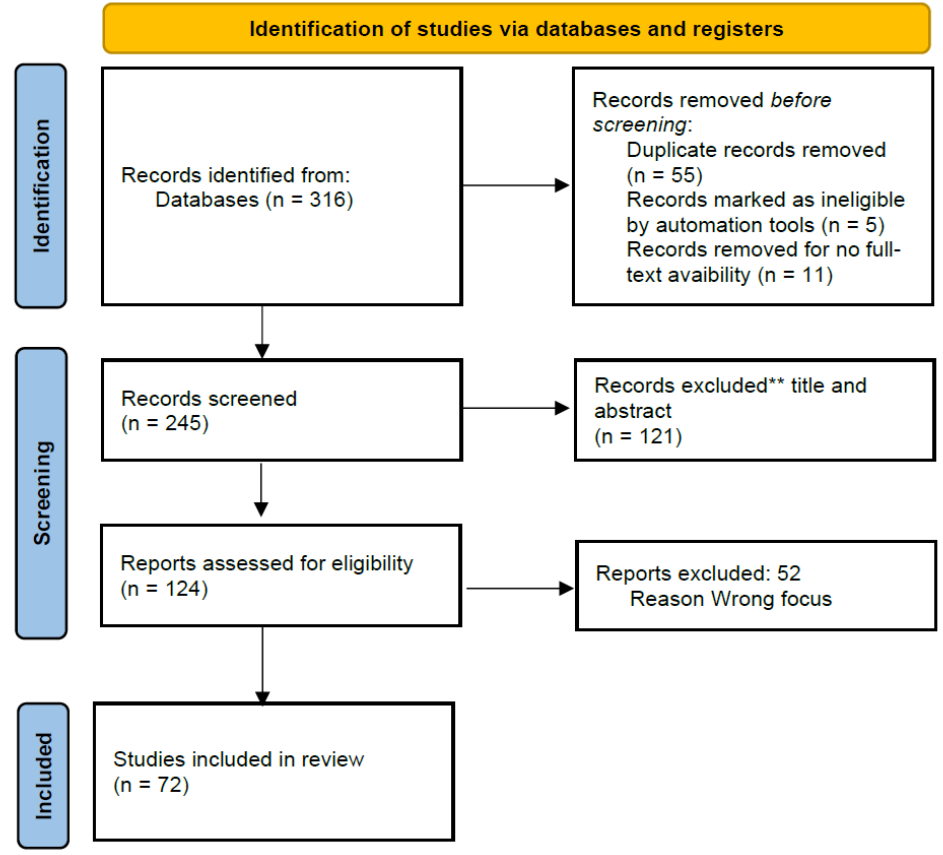
Figure 1. Flow diagram describing the review process, according to PRISMA statement.